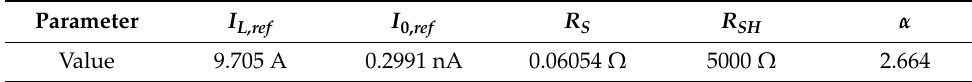
Table 1. Values of the de Soto model’s parameters. Parameter